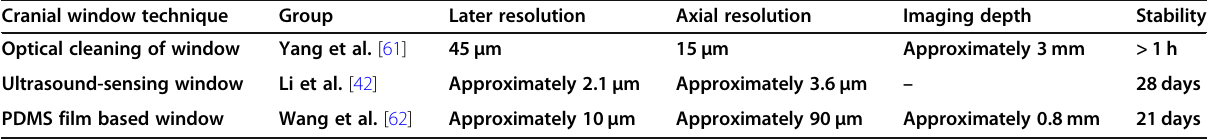
Table 1 The systemic parameters of chronic cranial window for PAI Cranial window